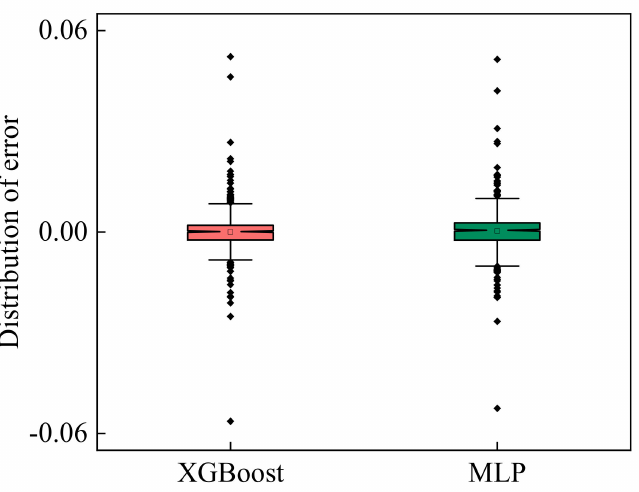
Figure 9. Distribution of prediction errors of the XGBoost model and MLP